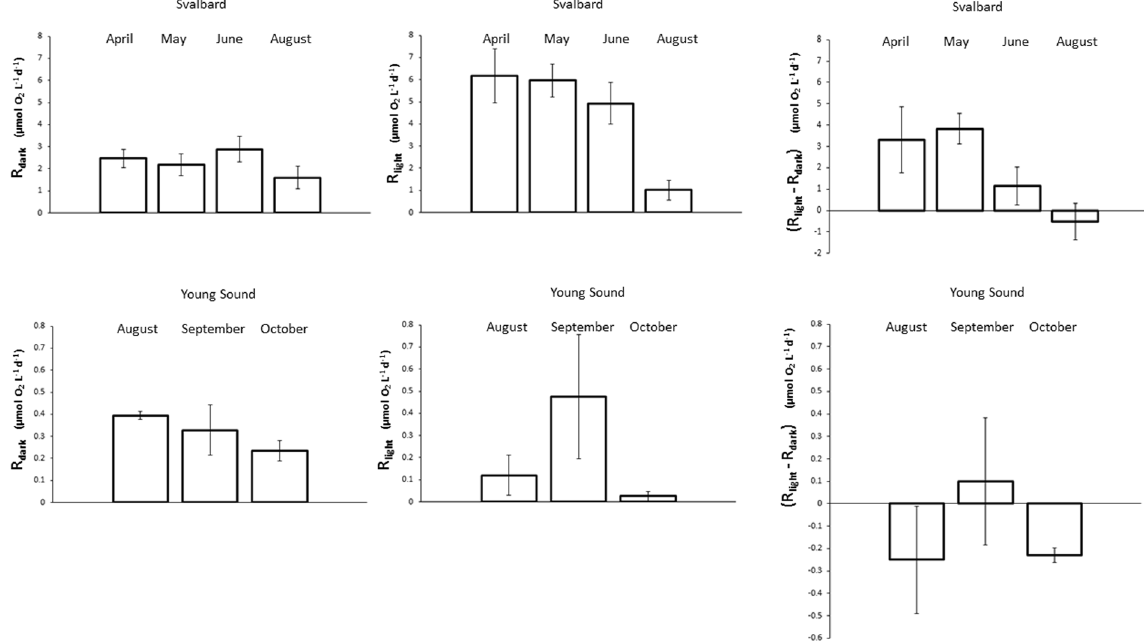
Figure 1. Mean ( ± SE) monthly respiration in the dark (R dark ), respiration in the light (R light ), and the difference between both (R light –R dark ) in the Svalbard region and Young